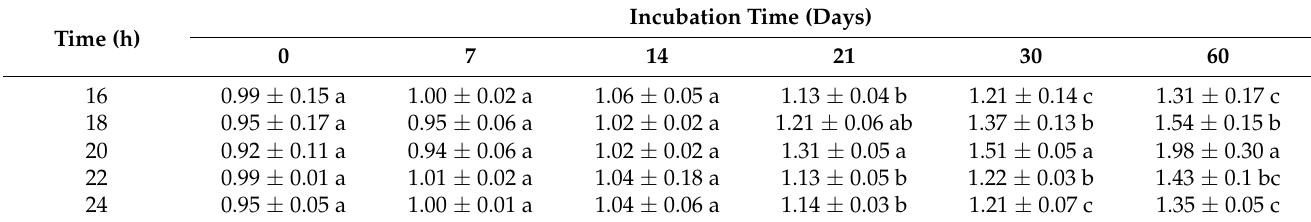
Table 6. Changes in the fresh weight of F. mandshurica embryogenic callus with different precul- ture